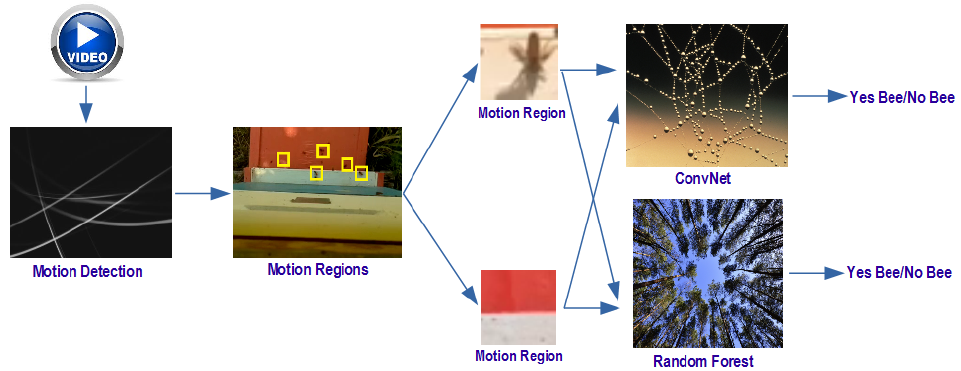
Figure 3. Bee motion counting in 2TA: tier 1 does motion region generation; tier 2 does motion region